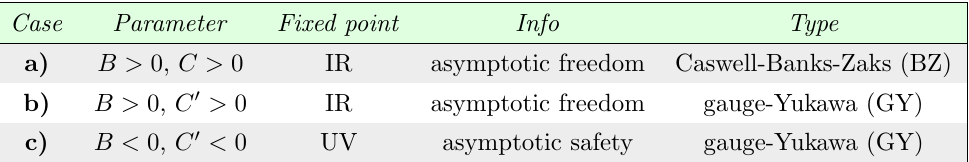
of simple gauge theories with (2.1) and their (cid:3)